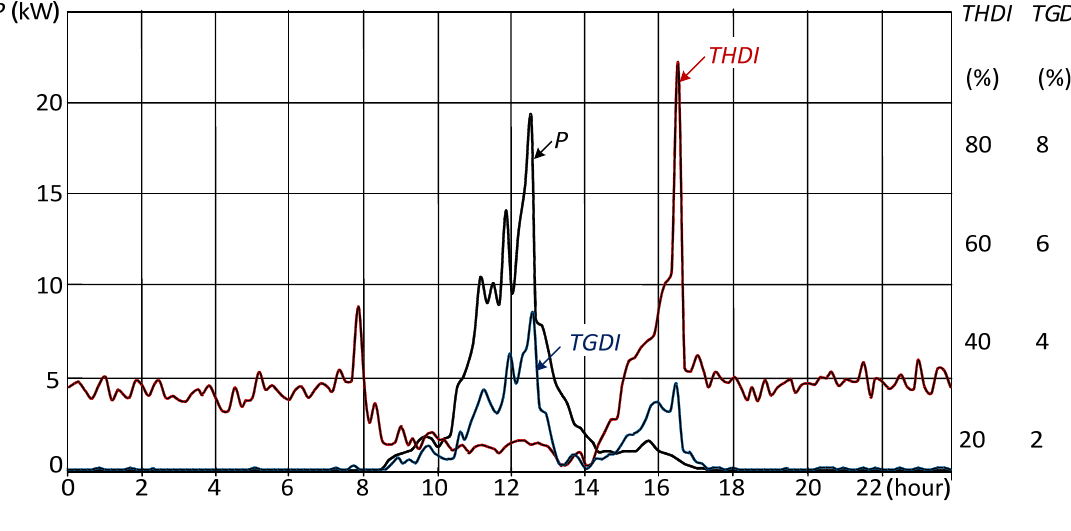
Figure 8. Correlation between the generated power, the total current harmonic distortion factor THDI and the total generator distortion index TGDI